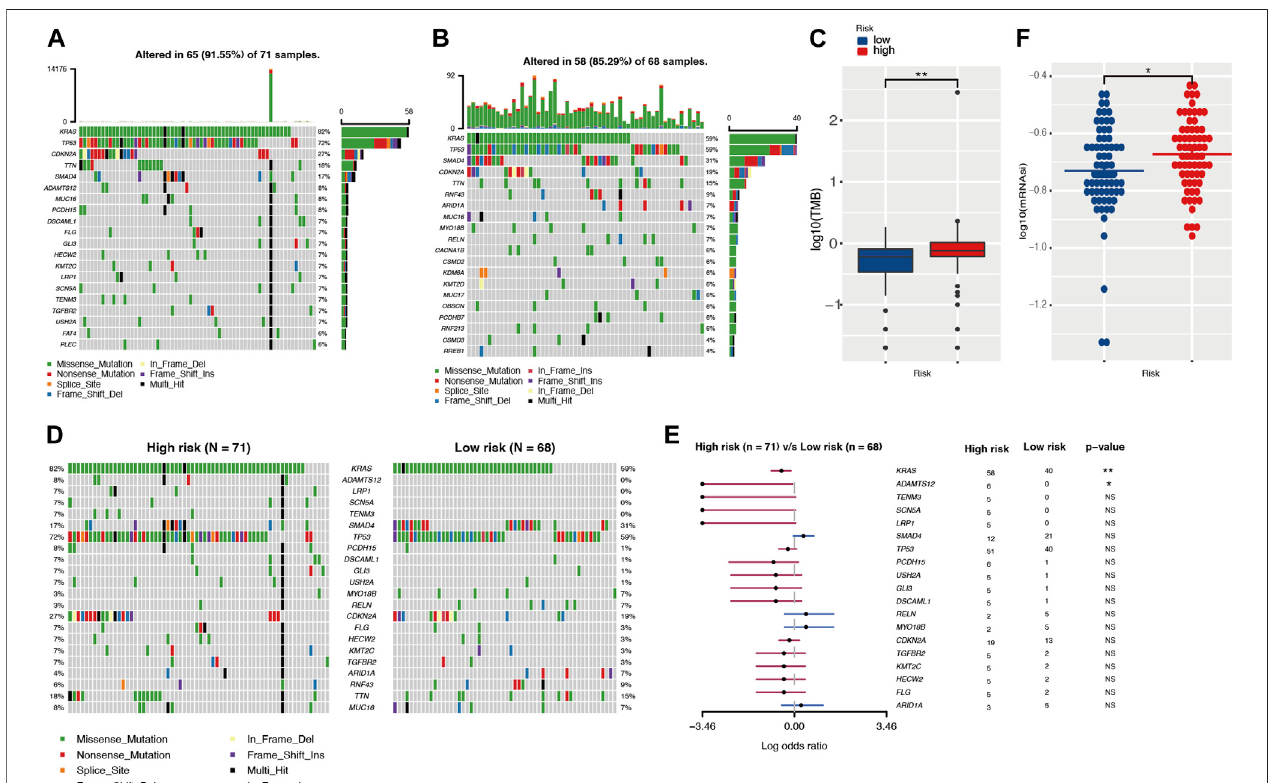
FIGURE 7 | The landscape of somatic mutation and tumor immune microenvironment in high- and low-risk cohorts. (A,B) The waterfall plot shows the mutation distribution of the top 20 most frequently mutated genes in high- and low-risk groups, respectively. The central panel shows the types of mutations. The upper panel shows the mutation frequency in each PDAC sample. The bar plots on the left show the frequency and mutation type of genes. The bottom panel is the legend for the mutation types. (C) Comparison of TMBs between high- and low-risk groups. (D,E) The waterfall plot and forest plot display the differentially mutated genes between the two cohorts. (F) Comparison of stemness indices between high- and low-risk groups. TMB, tumor mutation